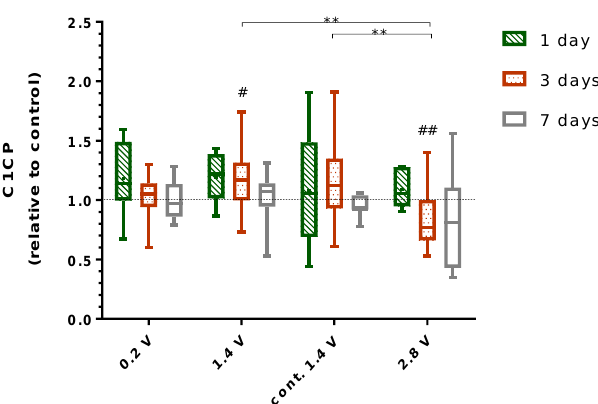
Figure 4. Collagen type 1 propeptide (C1CP) synthesised by human osteoblasts growing on electrodes and coverslips for one, three, and seven days. Peptide concentrations were determined from cell culture supernatant with and without electrical stimulation, and values are displayed relative to the unstimulated control for each time point. For this experiment, 0.2V, 1.4 V, and 2.8 V groups were stimulated 3 × 45 min per day, while the cont. 1.4 V group was stimulated continuously with 1.4 V. # indicates significant differences between the stimulated and control groups: # p < 0.05 and ## p < 0.01 (Wilcoxon matched pair test), * indicates significant differences between stimulation groups: ** p < 0.01 (two-way ANOVA). n ≥ 6.